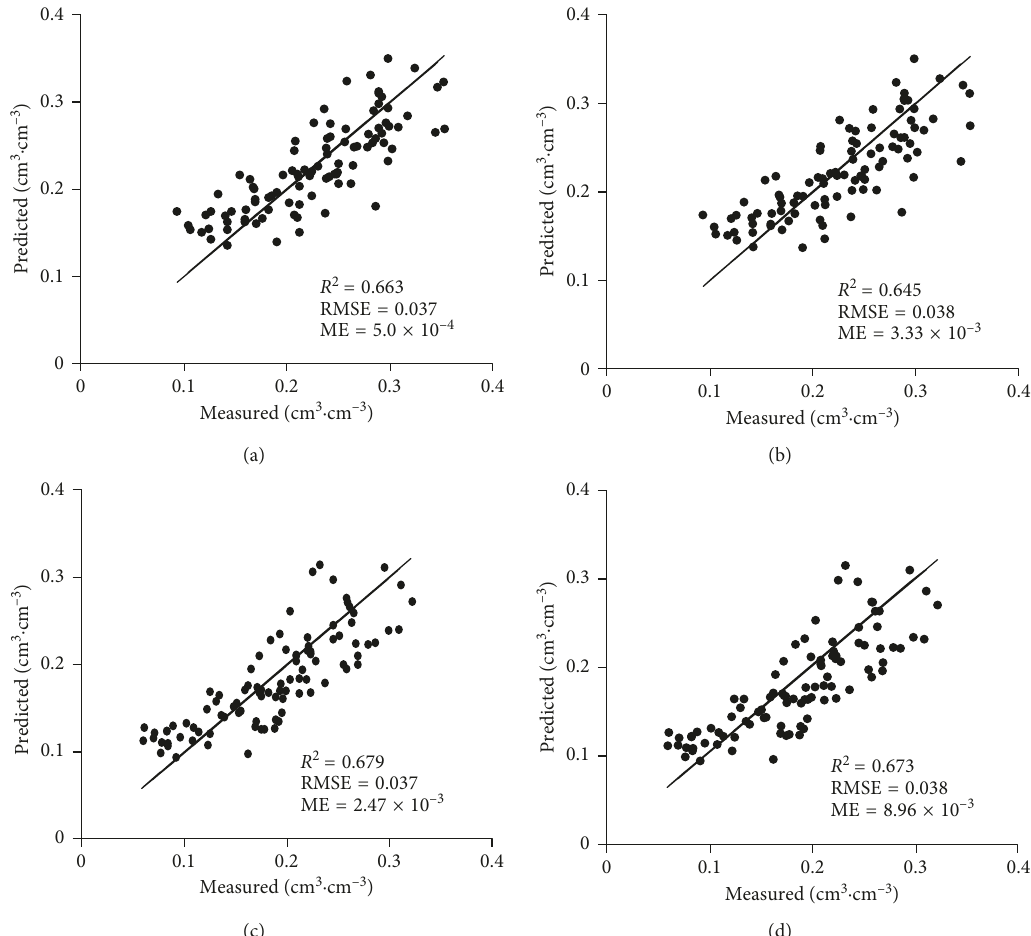
Figure 4: Unit plots of SVR- and MLR-predicted moisture content on the testing dataset. (a) SVR-FC3. (b) MLR-FC. (c) SVR-WP4. (d)